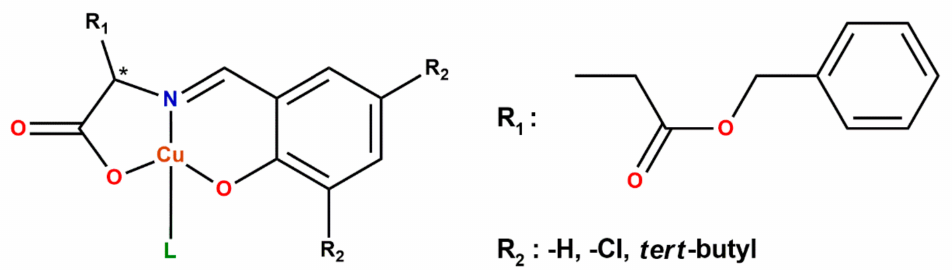
Figure 2. Ester type amino acid Schiff base Cu(II) complexes (* denotes an asymmetric carbon atom)